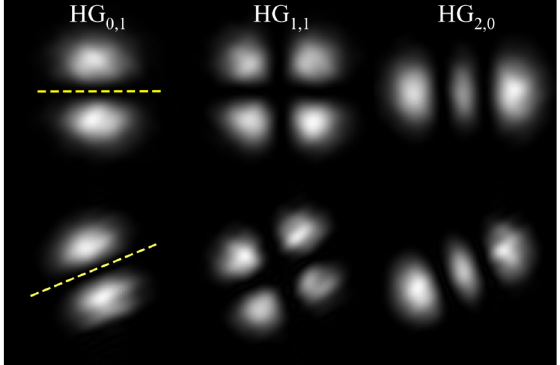
Figure 2: Image rotation: experimental images (from the camera’s perspective) of the original (top row) and rotated (bottom row) mode profiles for a fixed non-planar trajectory with 𝜃 indicated as yellow dashed